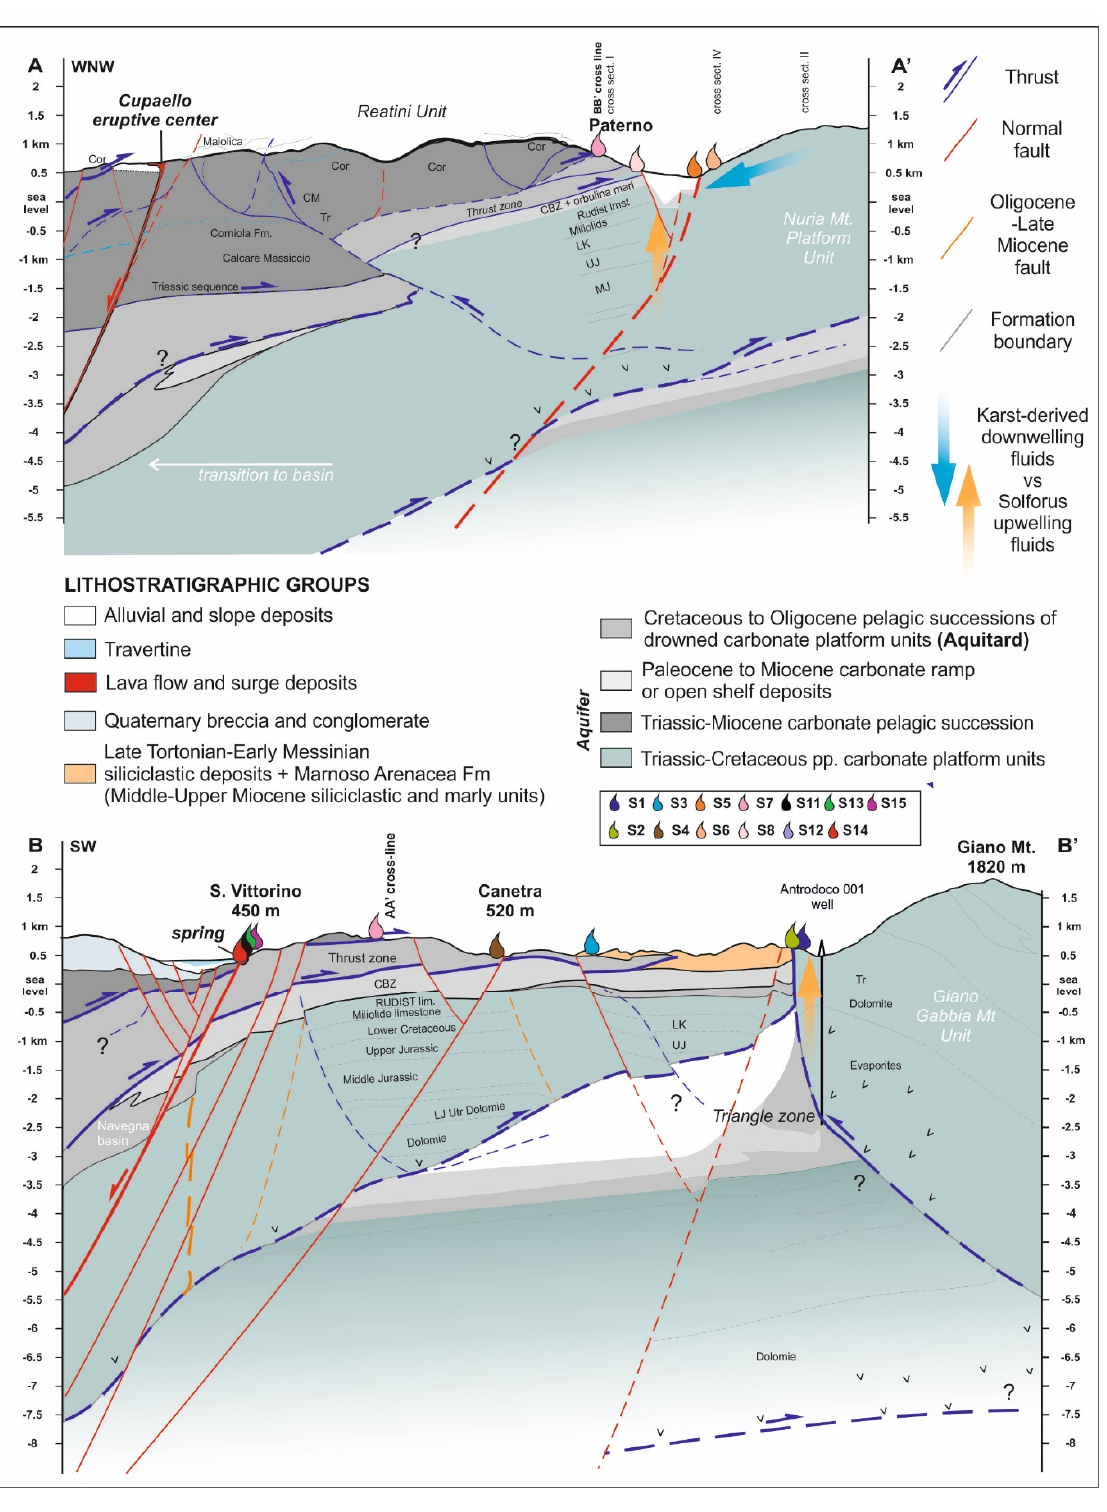
Figure 3 . Geological cross-sections showing a sketched reconstruction of the fold-and-thrust belt architecture, which is cross-cut by high-angle transtensive faults. The figure also shows the projection of the Antrodoco 001 well, which intercepts the backthrust tilting the Giano–Gabbia Mt. unit. See Figure 1 for the trace of the cross-sections and relative intersection from [54].